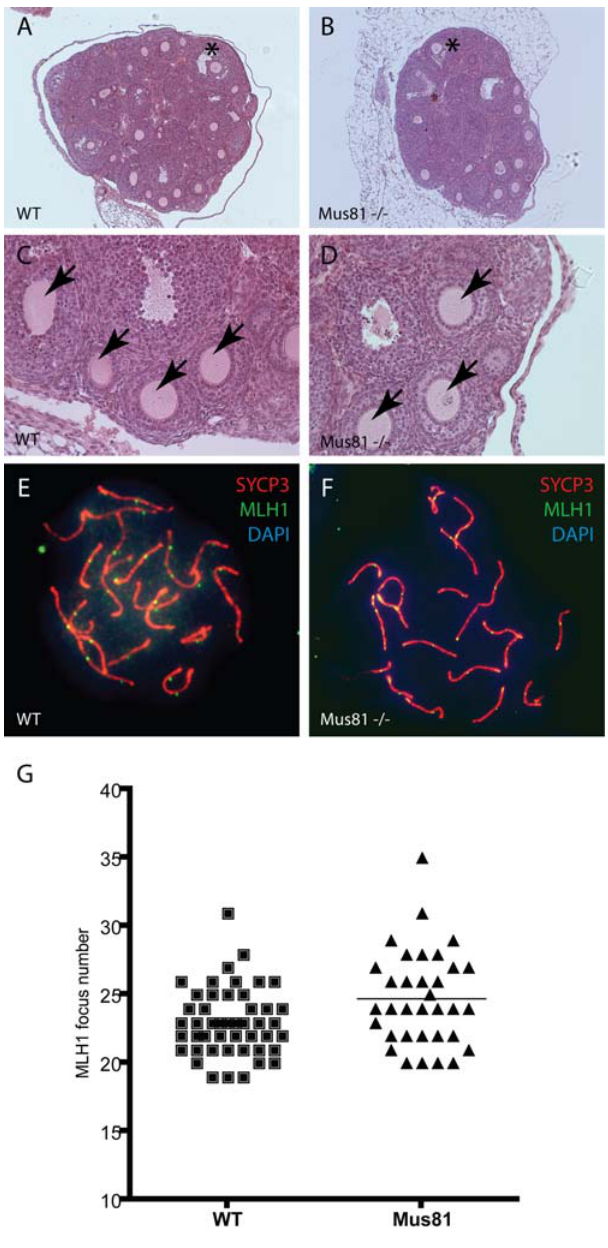
Figure 5. Meiotic Analysis in Mus81 2 / 2 females. WT (A, C) and Mus81 2 / 2 (B, D) day 22 pp ovaries sectioned and stained with H&E show normal oocyte development. Secondary (arrows) and antral (asterisk) follicles are present in both mutant and WT ovaries. MLH1 staining of WT (E) and Mus81 2 / 2 (F) oocytes from day e18.5 embryos show increased MLH1 foci in Mus81 2 / 2 tional MLH1–MLH3 events are not subject to the normal strict regulation of crossover placement that is essential to ensure division. Late in pachynema, spermatocytes from Mus81 2 / 2 males